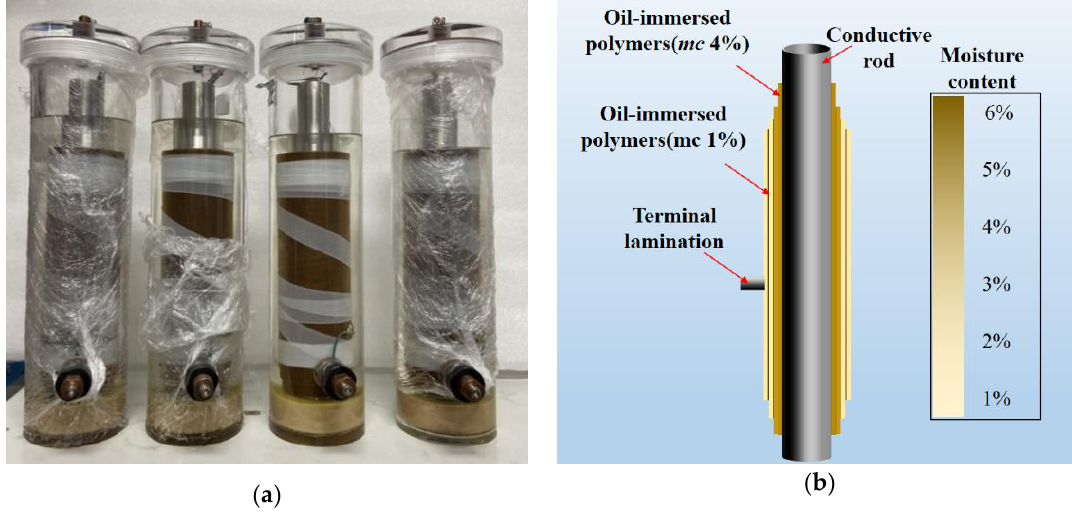
Table 1. 26 kV Capacitive Bushing Core Size.